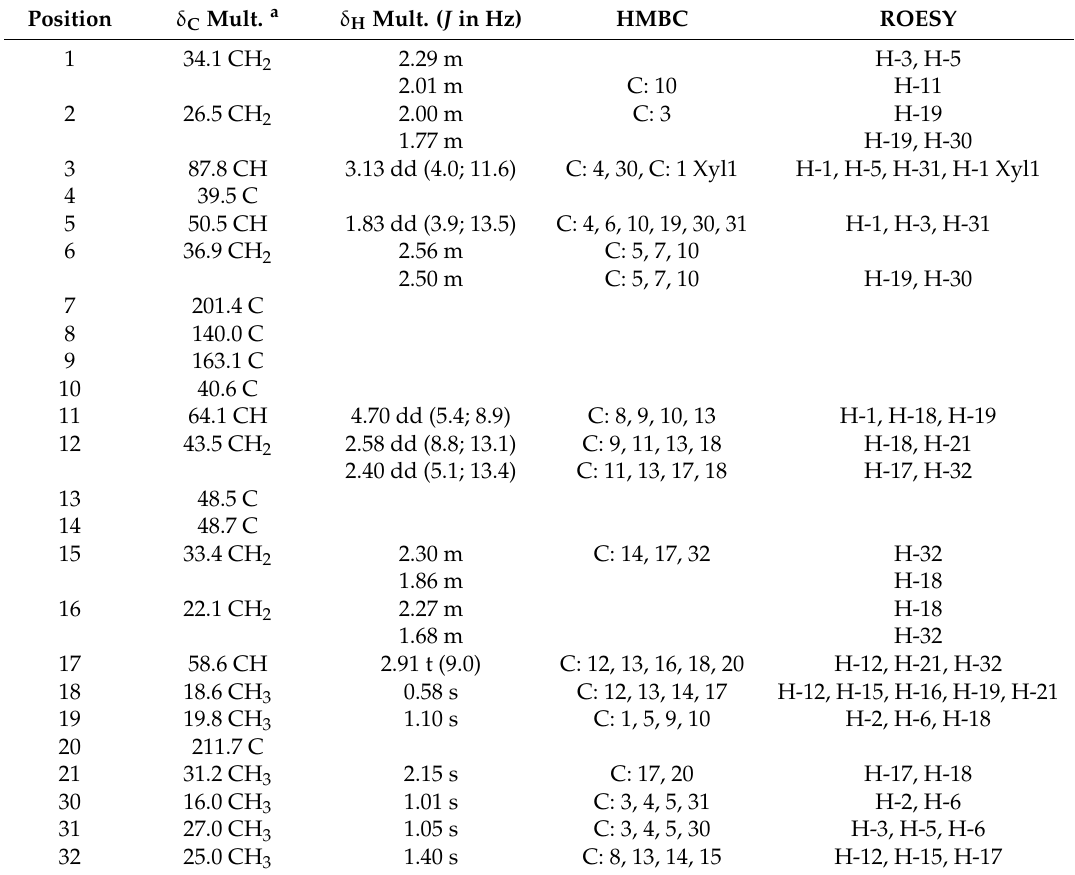
Table 3. NMR Spectroscopic data (700 MHz, C 5 D 5 N/D 2 O (4/1 v / v )) of the aglycone moiety of fallaxoside D 5 ( 2